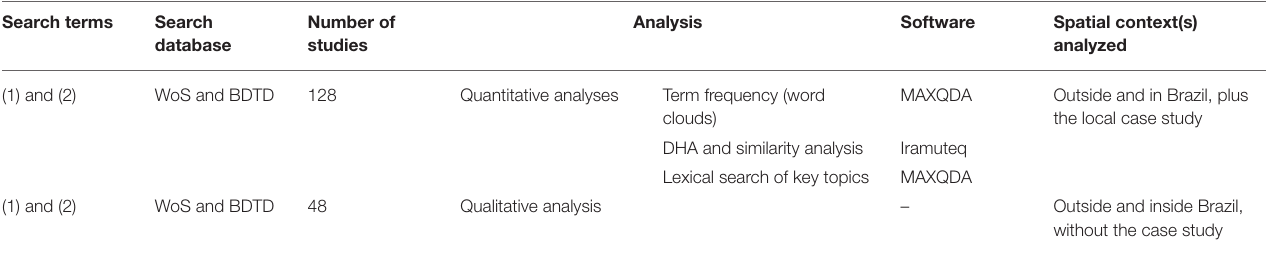
TABLE 2 | Overview of the analyses performed, with the systematization of documents according to the search database and the type of analysis for each spatial context (international, national, and local). Search